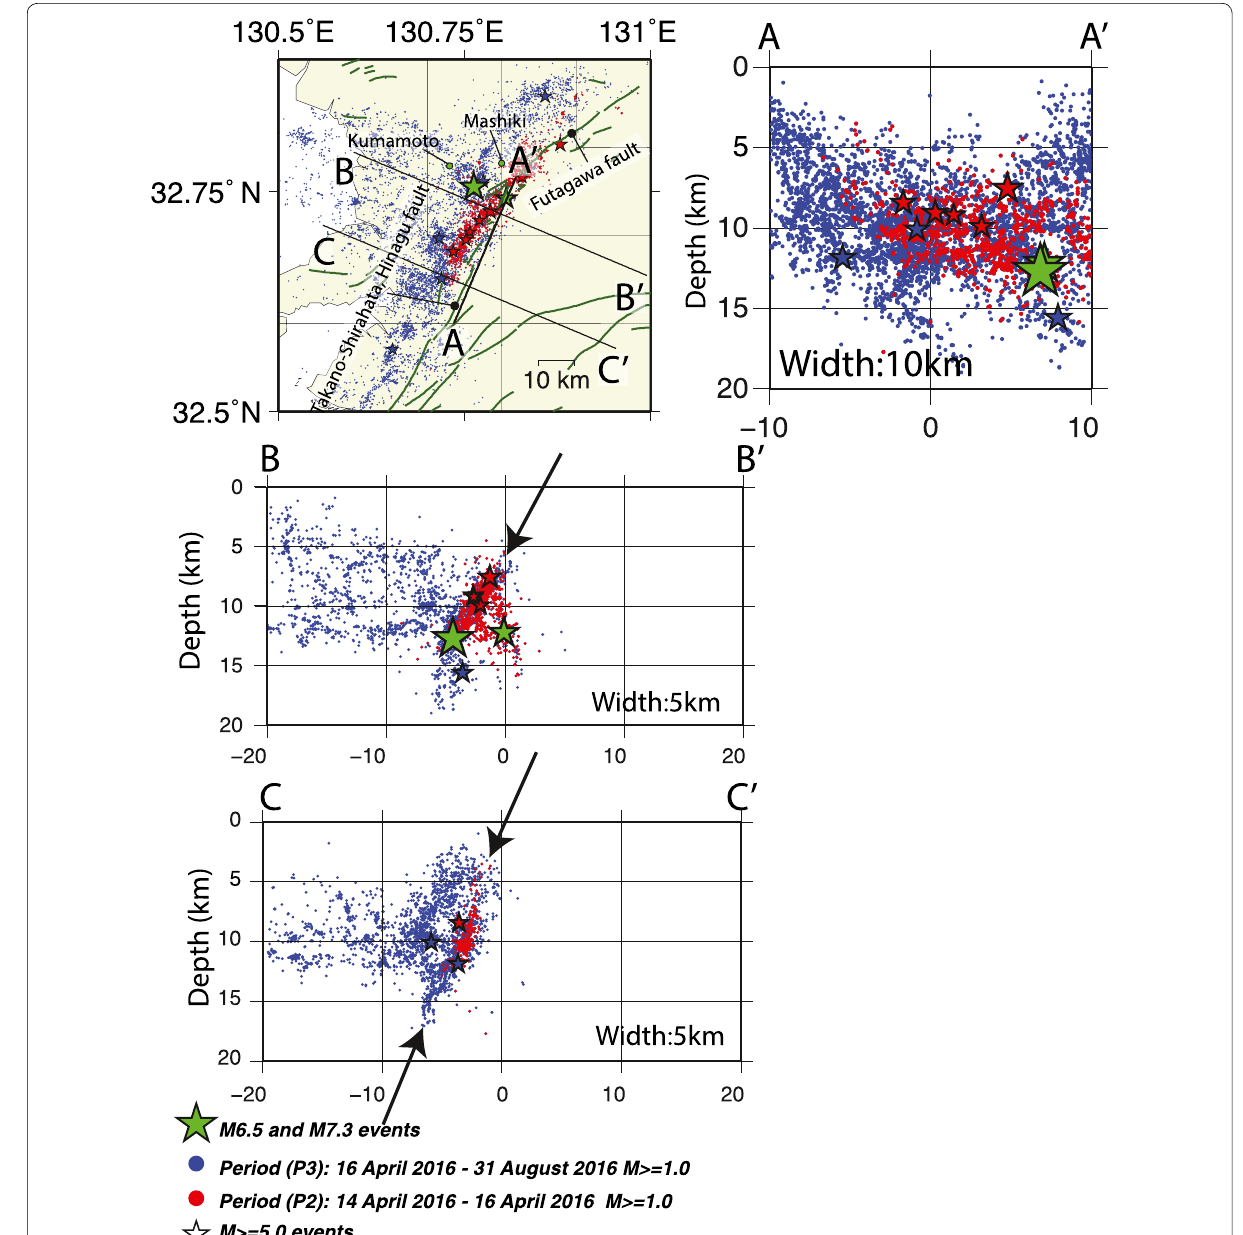
Fig. 2 Relocated hypocenter distribution and cross sections ( red and blue dots ) within the subregions (SR1), (SR2), and (SR3). This cross section fol- lows the Takano–Shirahata region of the Hinagu fault zone and runs close to the town of